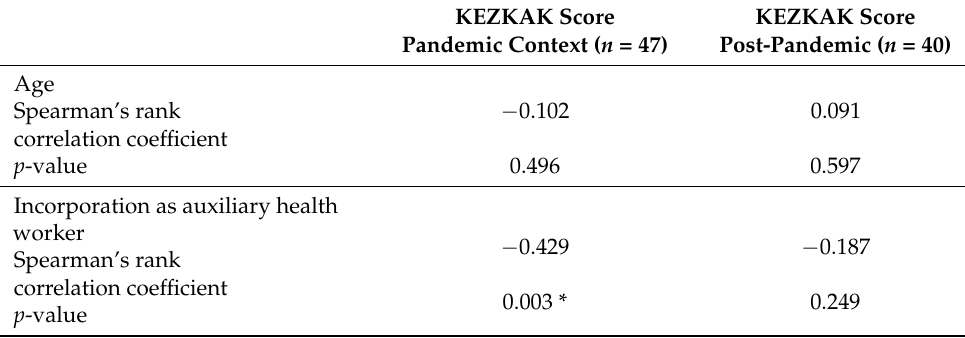
Table 3. Correlation between demographic characteristics and KEZKAK total score in a pandemic and post-pandemic